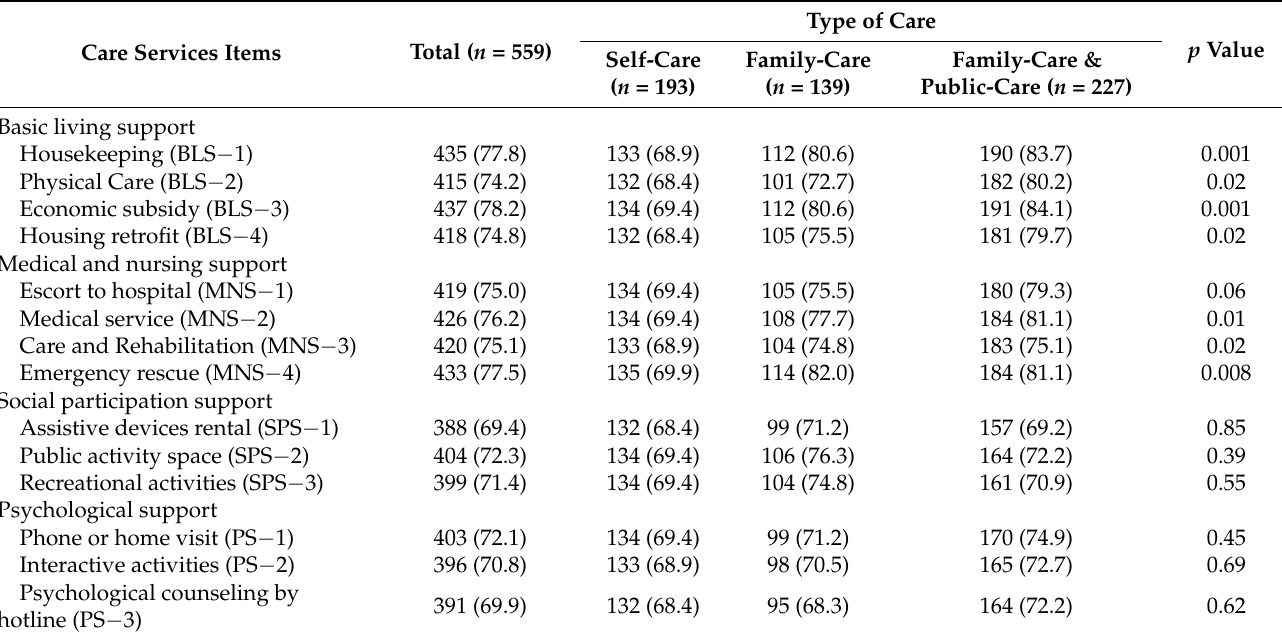
Table 4. Individual care needs for disabled elderly in different types of